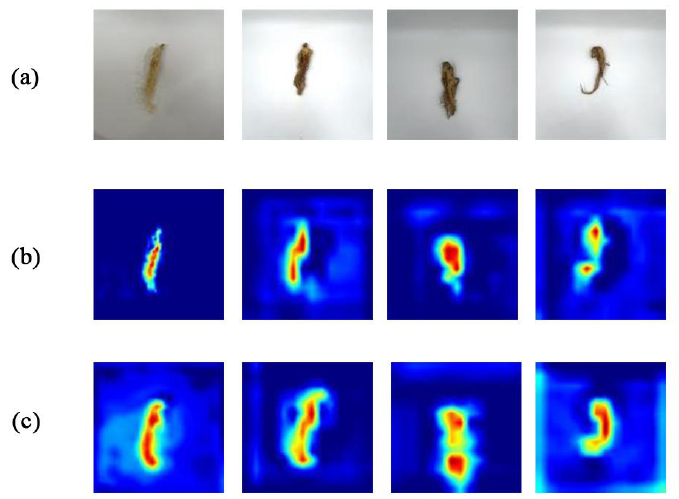
Figure 8. Visualization results of the thermal characteristic diagram of the new network before and after adding the ECA module. ( a ) Input image; ( b ) image before joining the ECA module; ( c ) image after adding the ECA module.